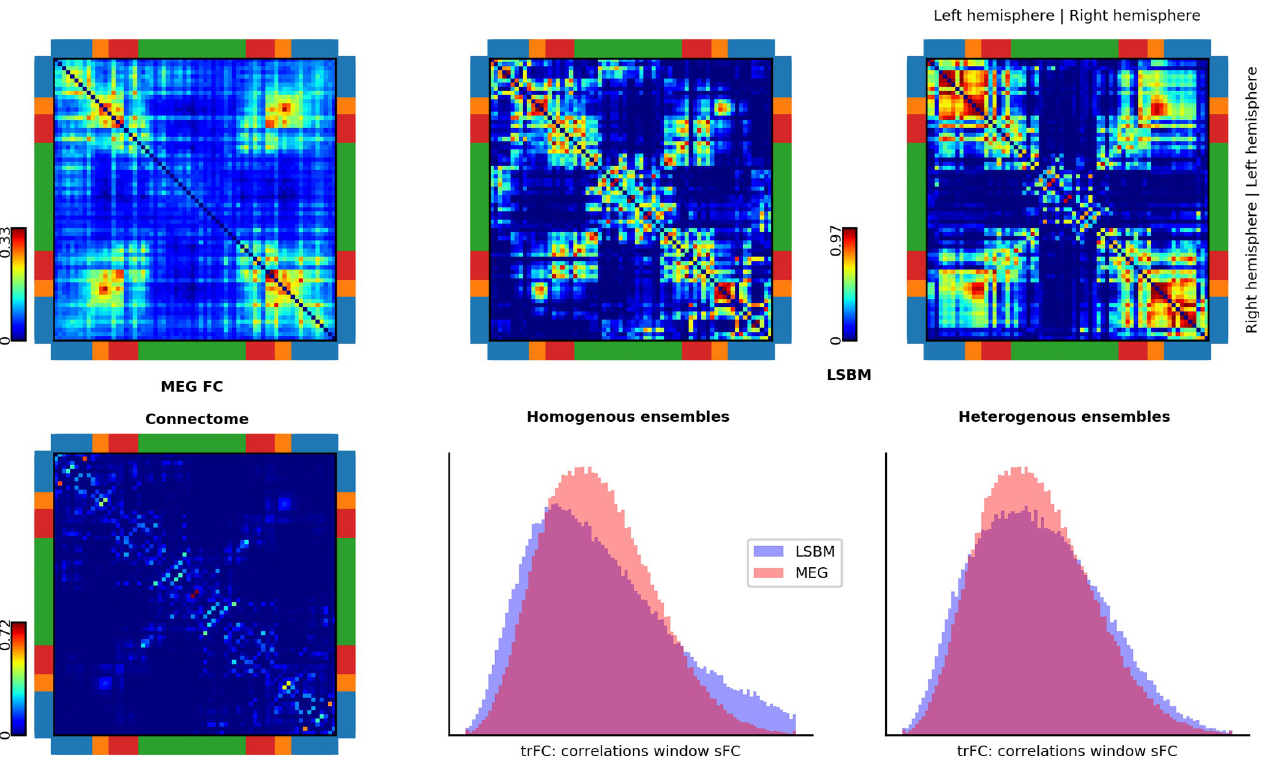
Fig 1. Connectome and FC from real MEG data and from simulations. First column shows resting-state MEG static FC (orthogonalized alpha band envelope correlations, top), and the anatomical network or connectome (bottom). The second and third columns show the FCs obtained from simulations with homogeneous and heterogeneous ensembles, respectively. The top row shows the static FCs. The bottom row shows the histograms of time-resolved FC recurrence (trFC: correlation of static FCs for 15 sec. moving window with 12 sec. overlap) for simulation (blue) and MEG data (pink). Brain lobes are color- coded around the connectivity matrices–blue, temporal; orange, occipital; red, parietal; and green, frontal.